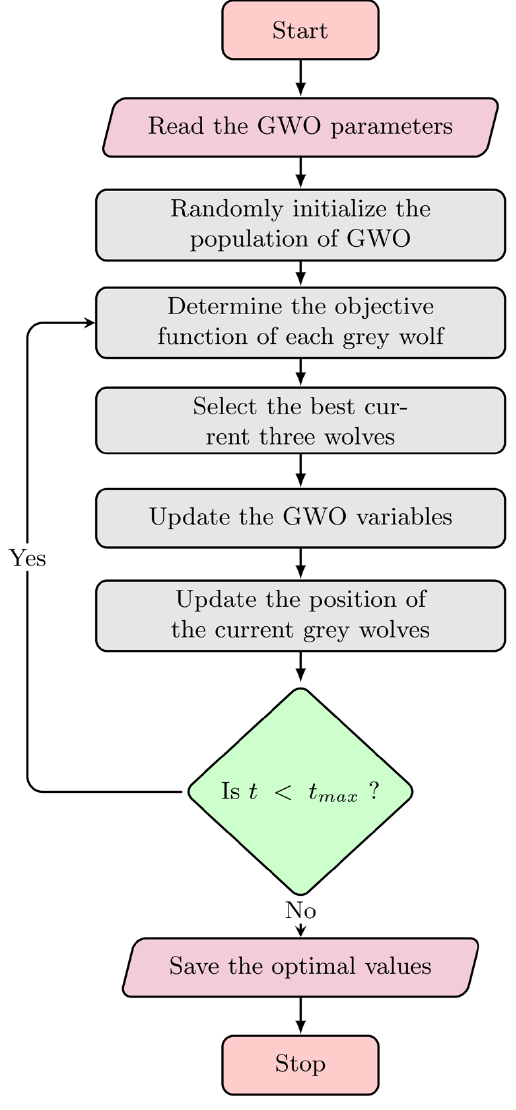
Figure 7. Flowchart of the metaheuristic GWO algorithm.